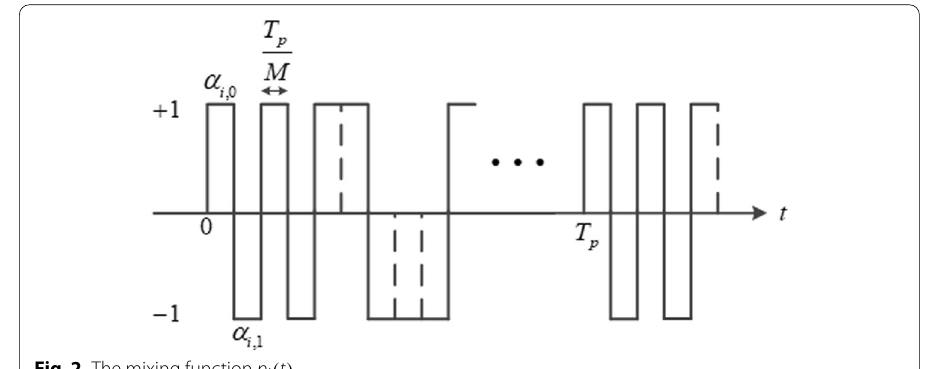
Fig. 2 The mixing function p i ( t